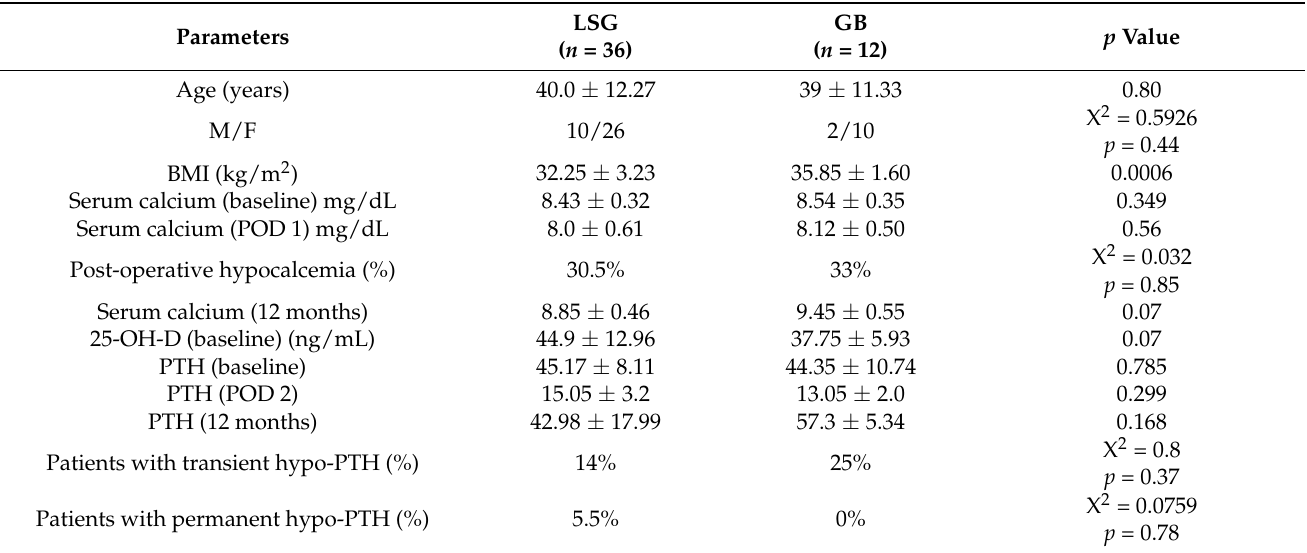
Table 2. Comparison between LGB and GB patients according to anthropometric, peri-operative, biochemical, and pathologic